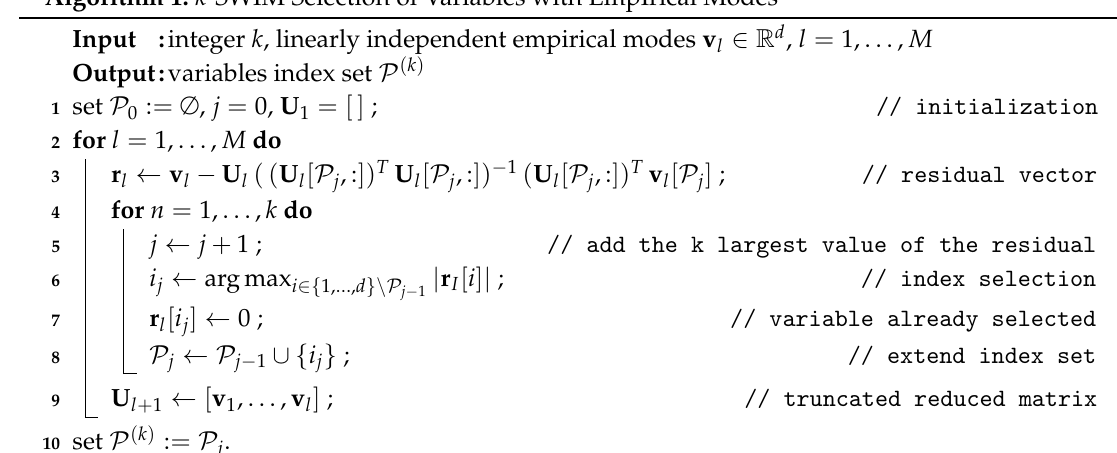
Algorithm 1: k -SWIM Selection of Variables with EmpIrical